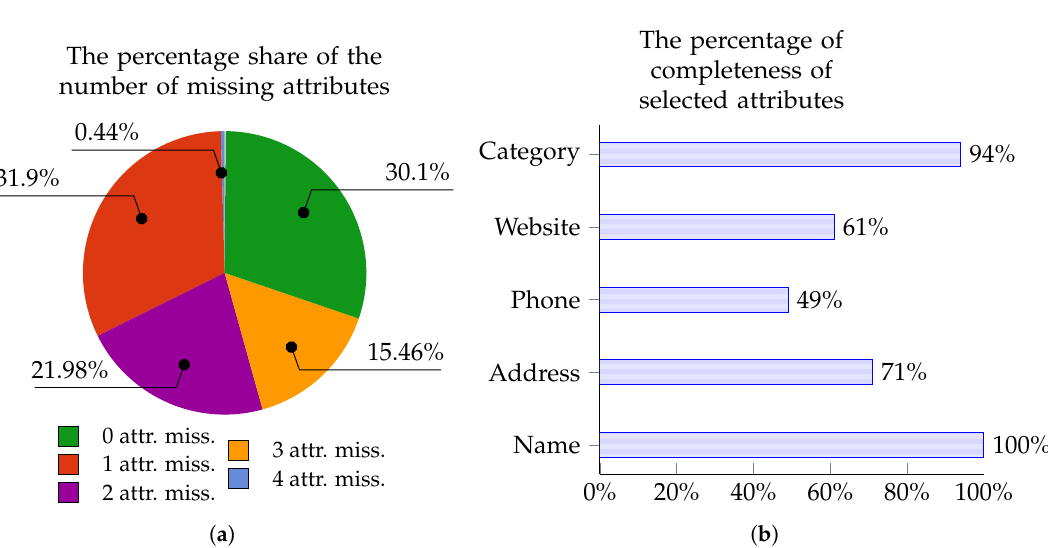
Figure 5. OpenStreetMap: The percentage of POIs with 0–4 missing attributes ( a ); and the percentage of completeness of selected attributes ( b ).